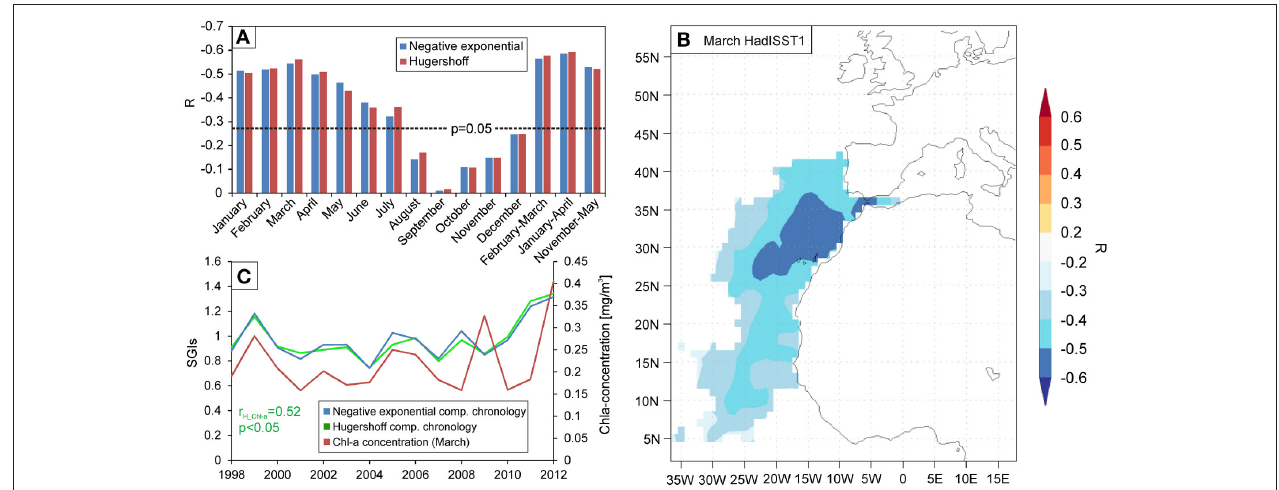
FIGURE 5 | Correlation patterns between the shell increment chronologies and the collected environmental data of the region of Madeira. (A) Correlation coefficients calculated between the standardized increment chronologies and monthly mean sea surface temperature of the region (HadISST, Rayner et al., 2003) for the period 1950–2012. Negative exponential—detrended arstan chronology is represented by blue bars, Hugershoff -detrended arstan chronology is represented by red bars, and the dashed line corresponds to the p = 0.05 significance level. (B) Spatial correlation analysis between the gridded March HadISST field around Madeira and the Hugershoff-detrended arstan chronology calculated over the period 1950–2012. Colored areas are significant at p < 0.05 level. (C) Annual variation in March chlorophyll- a content of the surface waters of the region (red line) compared to the two chronologies between 1998 and